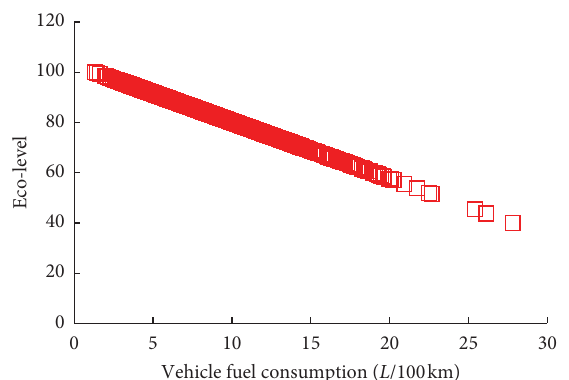
Figure 2: The relationship between eco-level and fuel consumption in the basic segments of urban expressways.